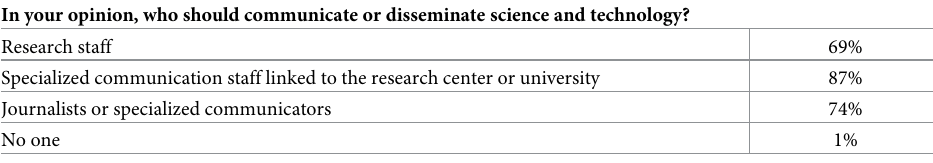
Table 9. Scientists’ views of who has to communicate or disseminate science and